Question: What style of plot is this figure drawn as?
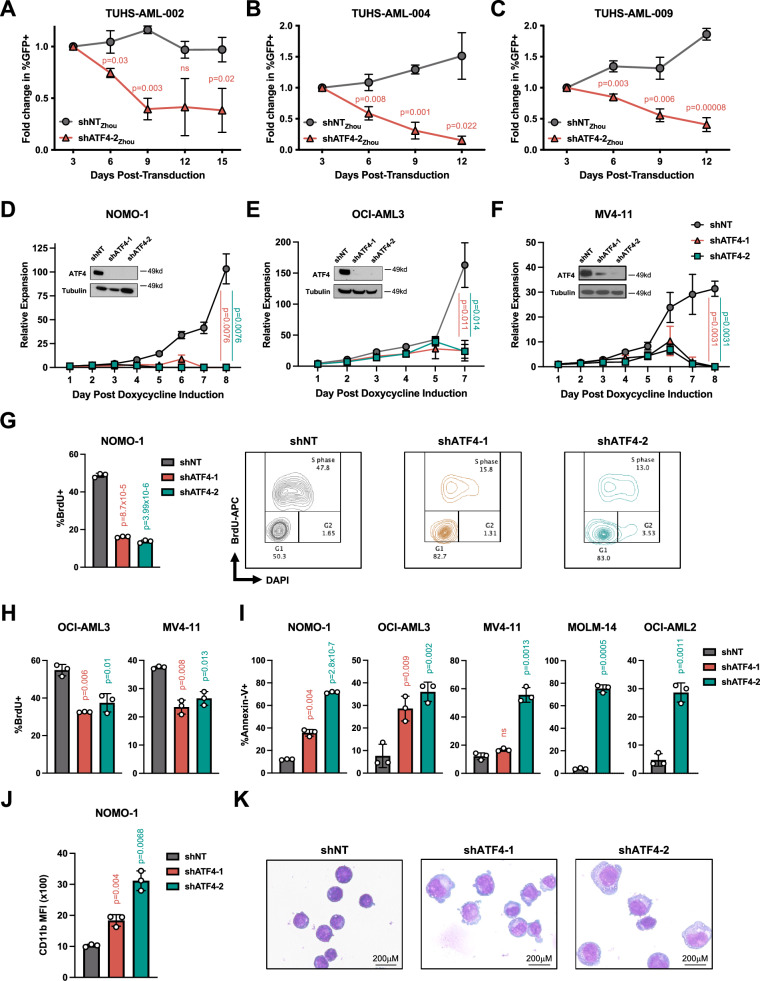
Answer: histogram